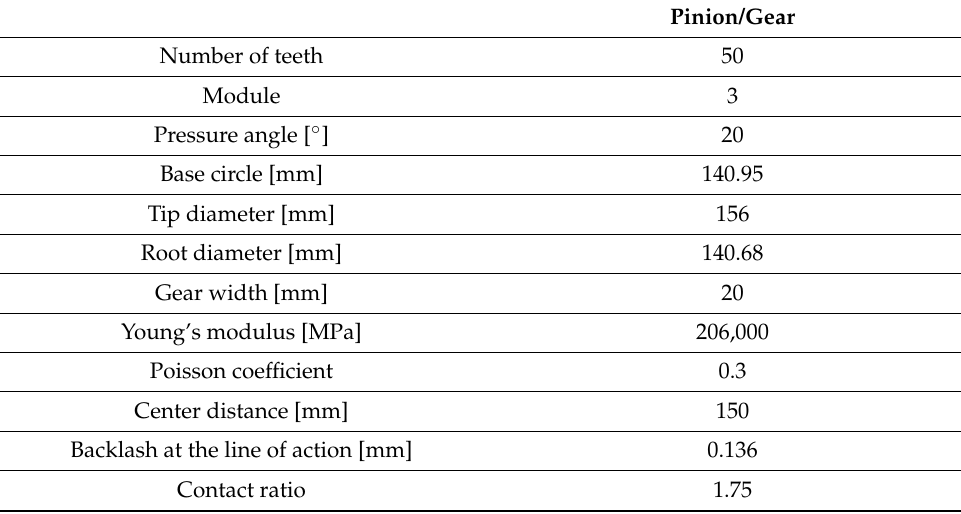
Table 1. Test gear parameters used in Ref [17,23].